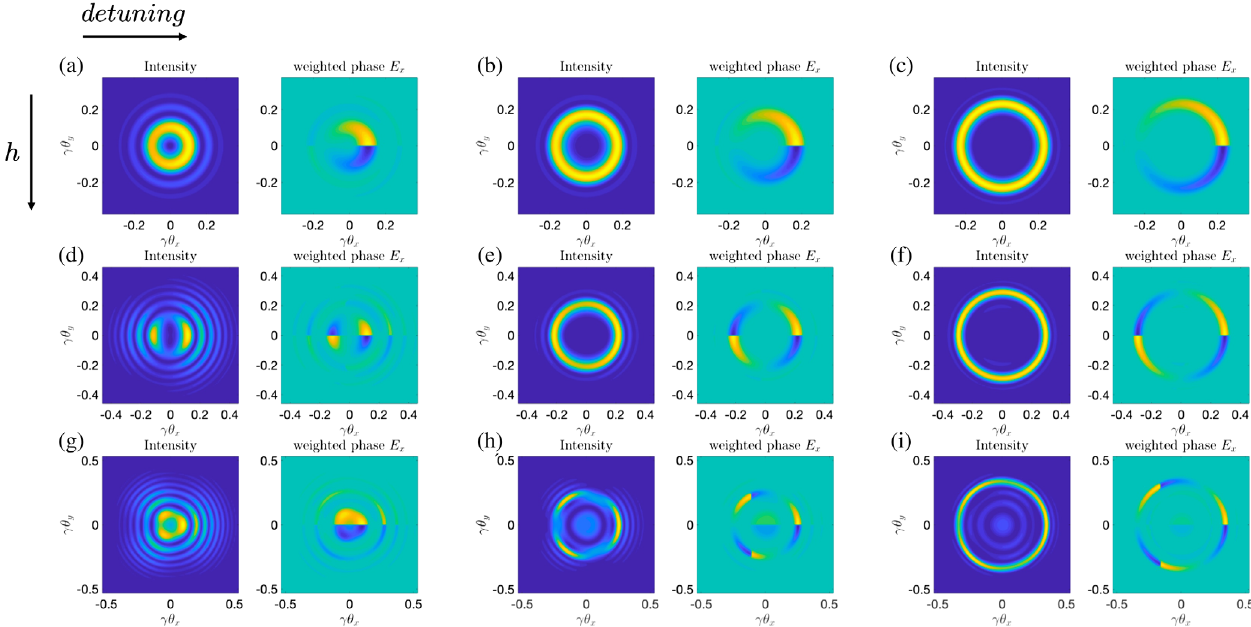
FIG. 4. Coherent OAM emission for different LHU harmonics (rows) and undulator detuning (columns). Top to bottom the rows are harmonics h ¼ 2 , h ¼ 3 , and h ¼ 4 , respectively, with resonant undulator strengths K 2 ¼ 2 . 3 , K 3 ¼ 2 . 9 , and K 4 ¼ 3 . 4 . The 4 GeV ¼ 100 periods of λ ¼ 3 . 9 cm. The detuning increases left to right according to beam is bunched at λ ¼ 1 nm, and the undulator has N u u ð 1 − δ Þ , with δ ¼ 0 , 1 = 4 N K → K , and 1 = 2 N . The annular intensity profile is observed to expand and become more symmetric with h u u detuning, which, with the phase, indicates that the power is directed into a single OAM mode. The phase is weighted by the intensity for ¼ 5 μ m e-beam ( N ¼ 0 . 04 ) is modeled to highlight the effect of detuning without strongly suppressing the better visibility. A small σ x